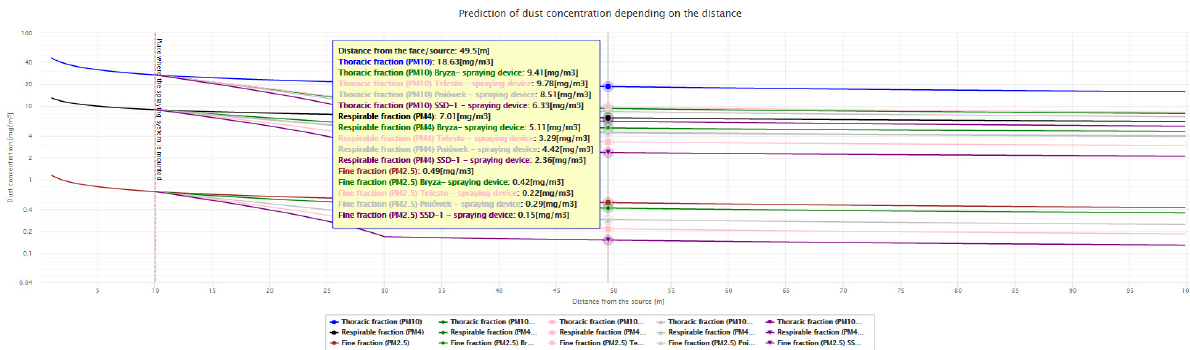
Figure 23. Graphical window to display the predicted dust concentration (PM10, PM4, and PM2.5) with and without spraying devices.